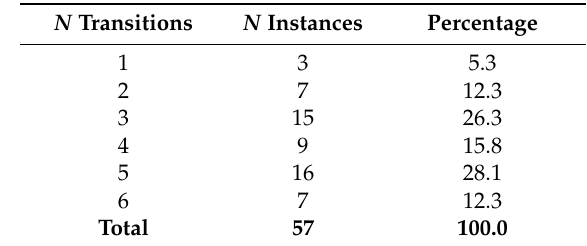
Table 1. Number of instances according to the number of transitions journals experienced from Q4 to